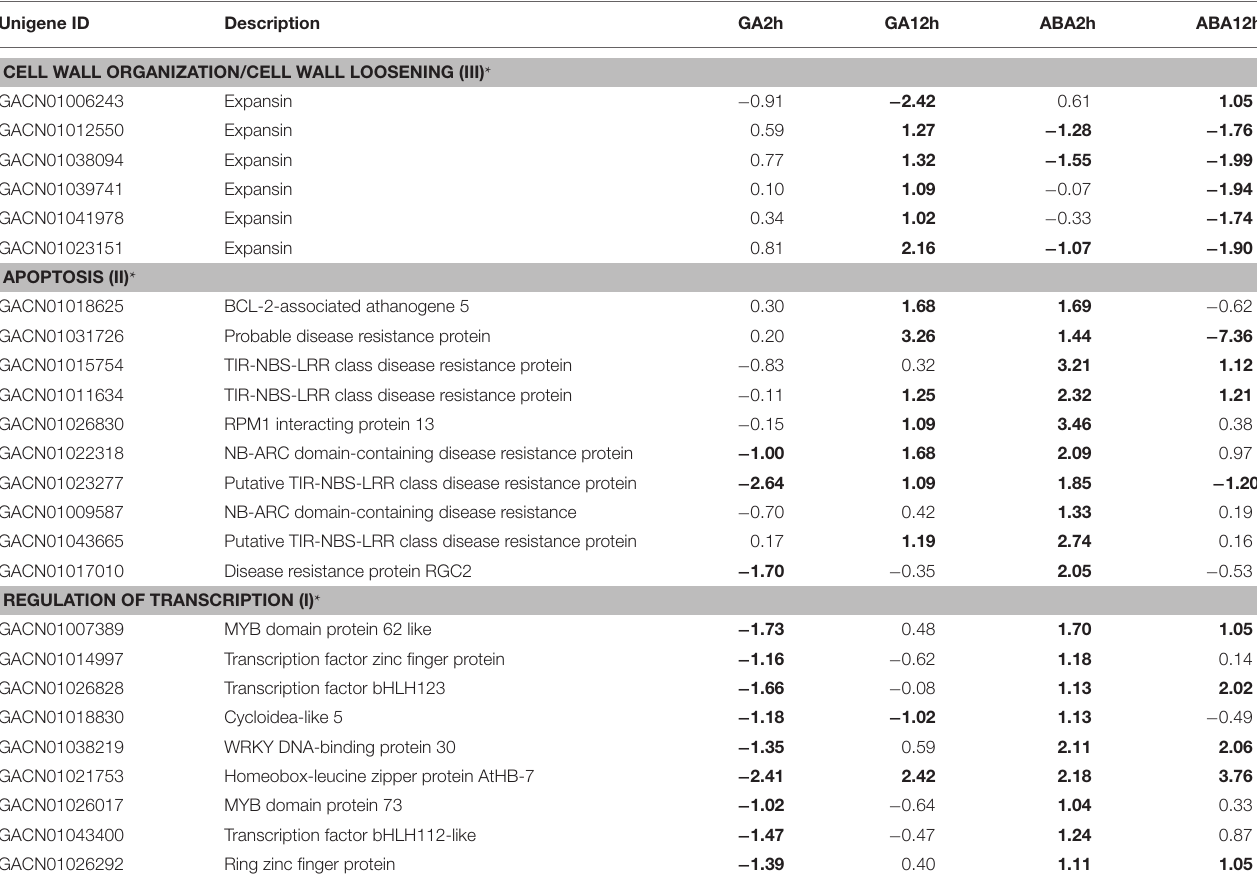
TABLE 2 | DEGs with enriched GO